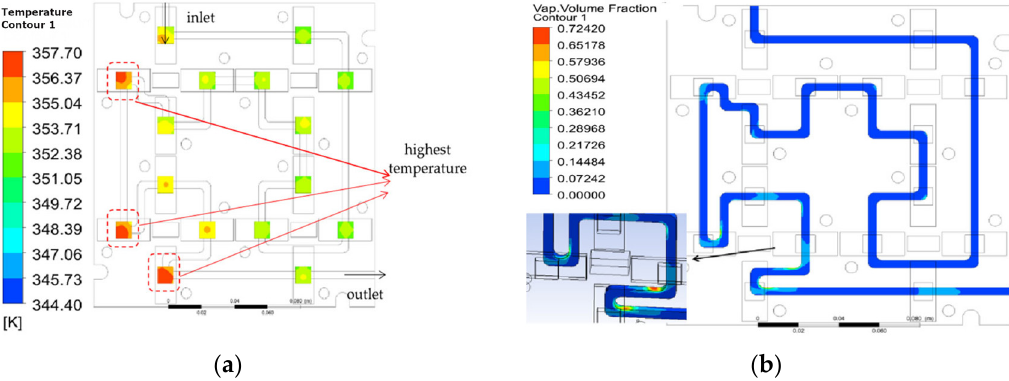
Figure 6. ( a ) Temperature distribution of heat sources; ( b ) vapor − phase distribution of the channel.